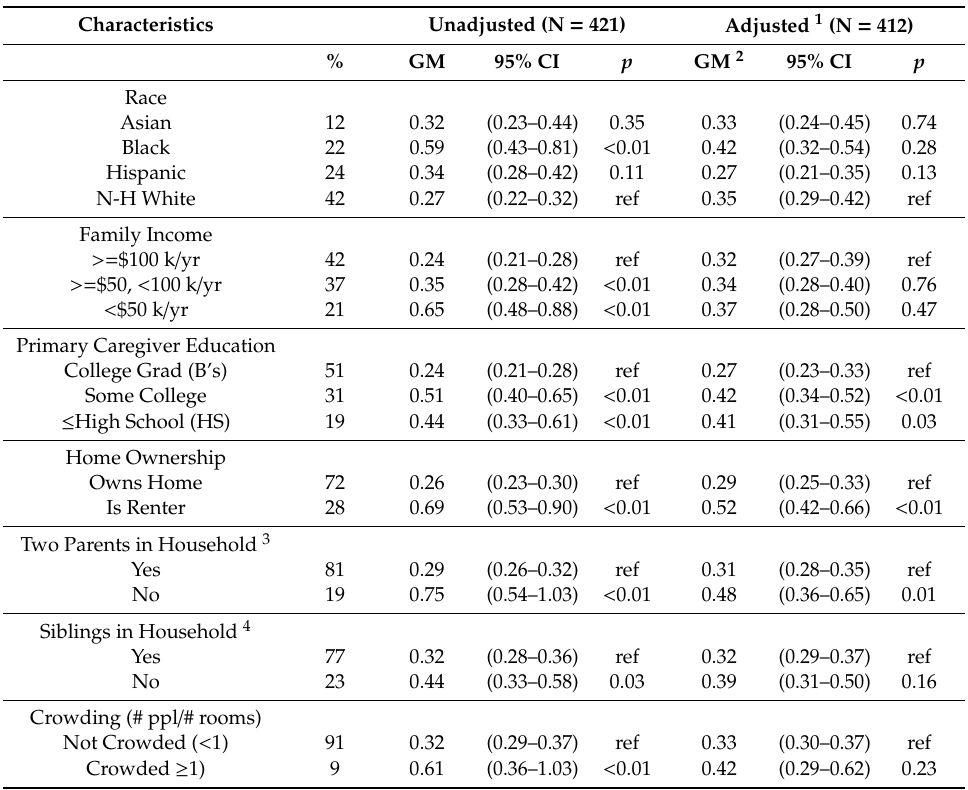
Table 2. Urinary Cotinine ( µ g / g creatinine) Geometric Means (GM) by Demographic and Household